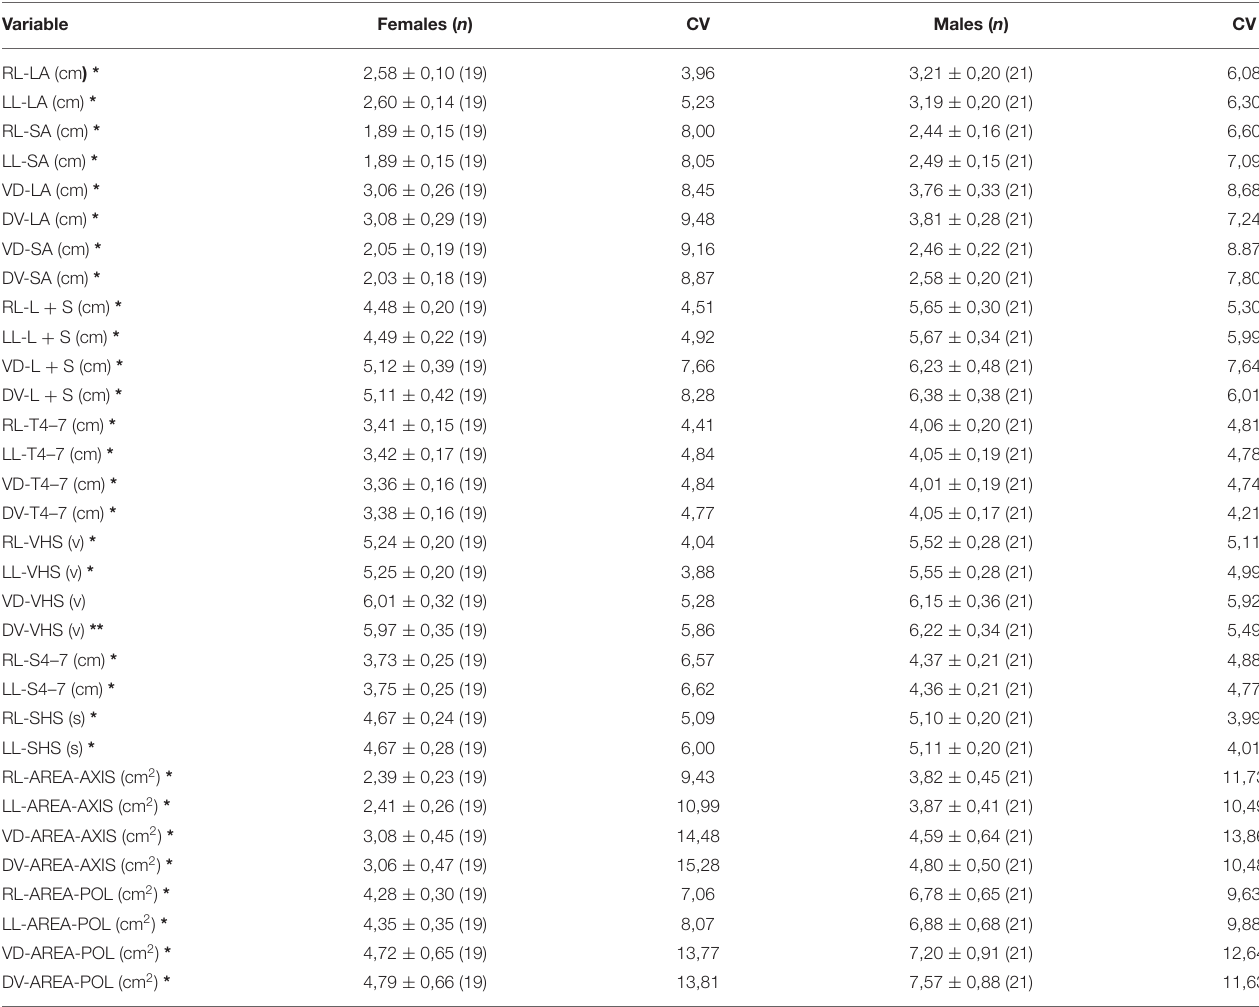
TABLE 2 | Comparison of radiographic measurements between males and females healthy ferrets.